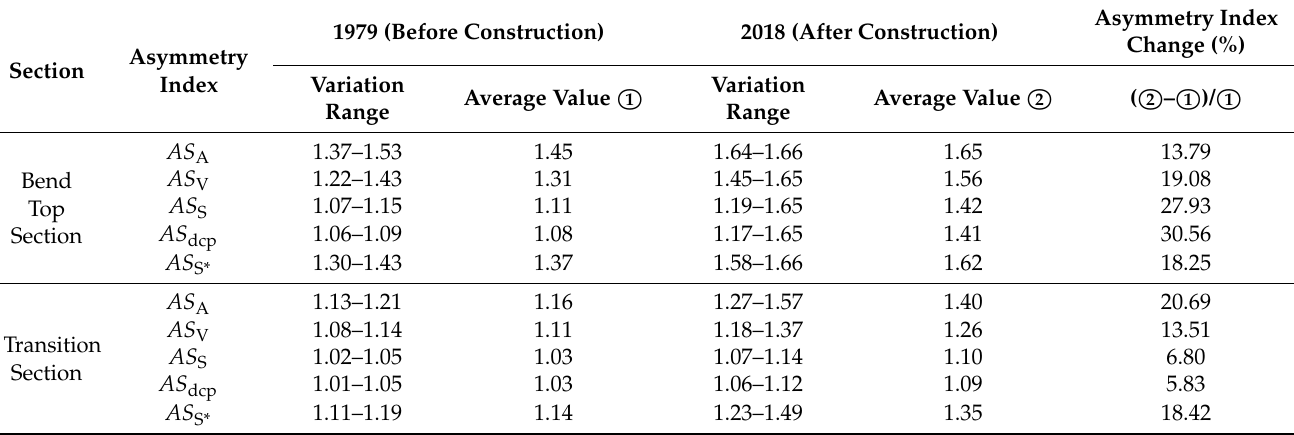
Table 7. Comparison of asymmetry indexes of various factors before and after